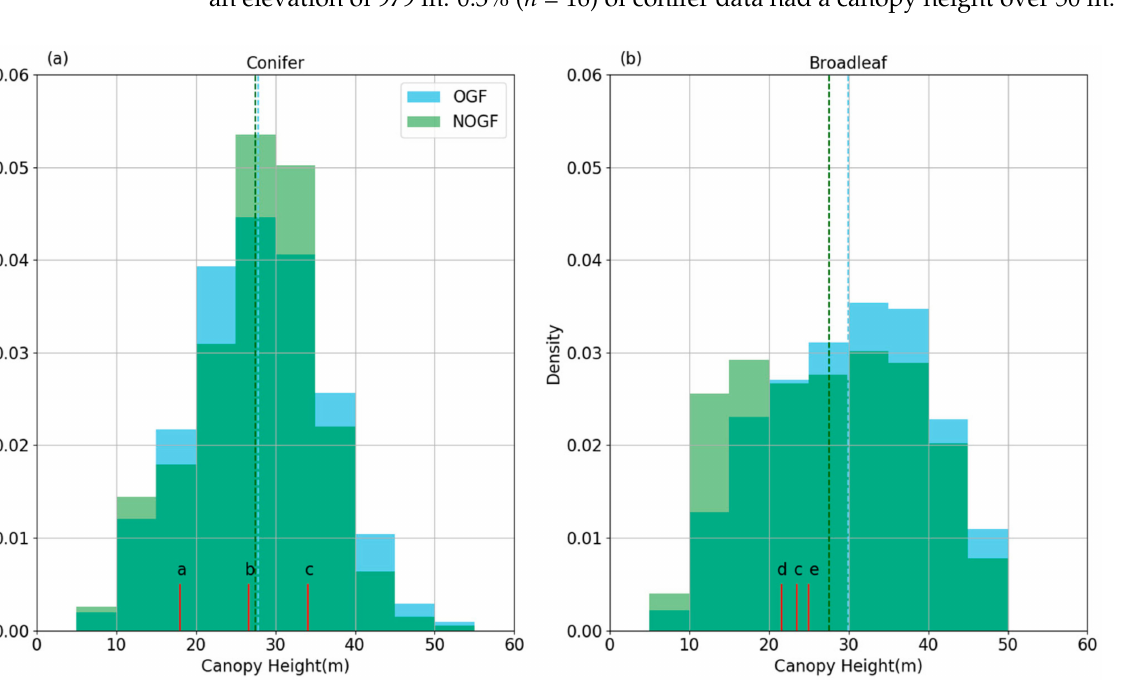
Figure 6. Histograms of canopy height (rh 100 ) for ( a ) conifer old-growth forest (OGF) and non-OGF (NOGF) and ( b ) broadleaf OGF and NOGF. y -axis gives the probability density: each bin displays the count divided by the total number of counts and the bin width of 5 m. The area under the histogram, therefore, sums to 1. The dotted vertical blue and green lines give the mean heights of the OGF and NOGF respectively. Red vertical lines give the mean canopy heights from five field studies of OGF in the Carpathian Mountains: a: [63], b: [64], c: [59], d: [57], e: